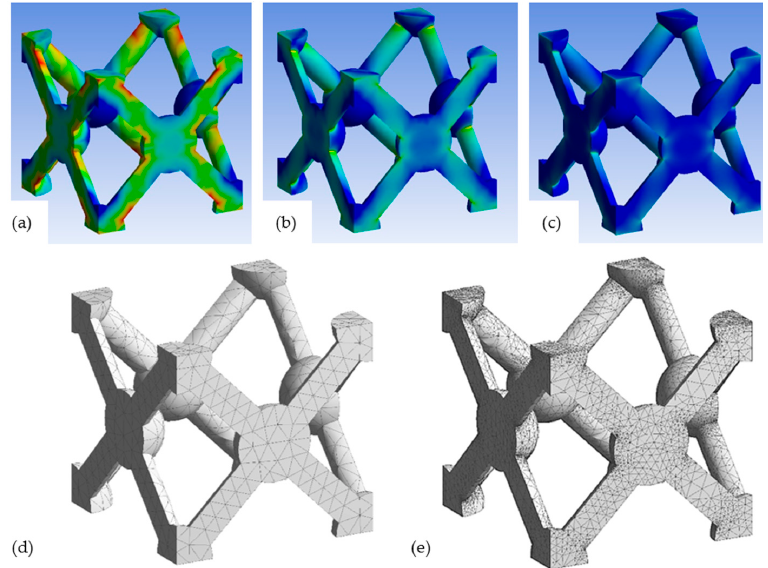
Figure 15. Images of BCC UC showing: ( a ) stress results with initial uniform mesh; ( b ) stress results after four mesh iterations; ( c ) stress results after eight iterations ( d ) initial uniform mesh; ( e ) mesh after eight iterative refinements including areas of high stress densely packed with tetrahedral elements smaller than a nanometer.